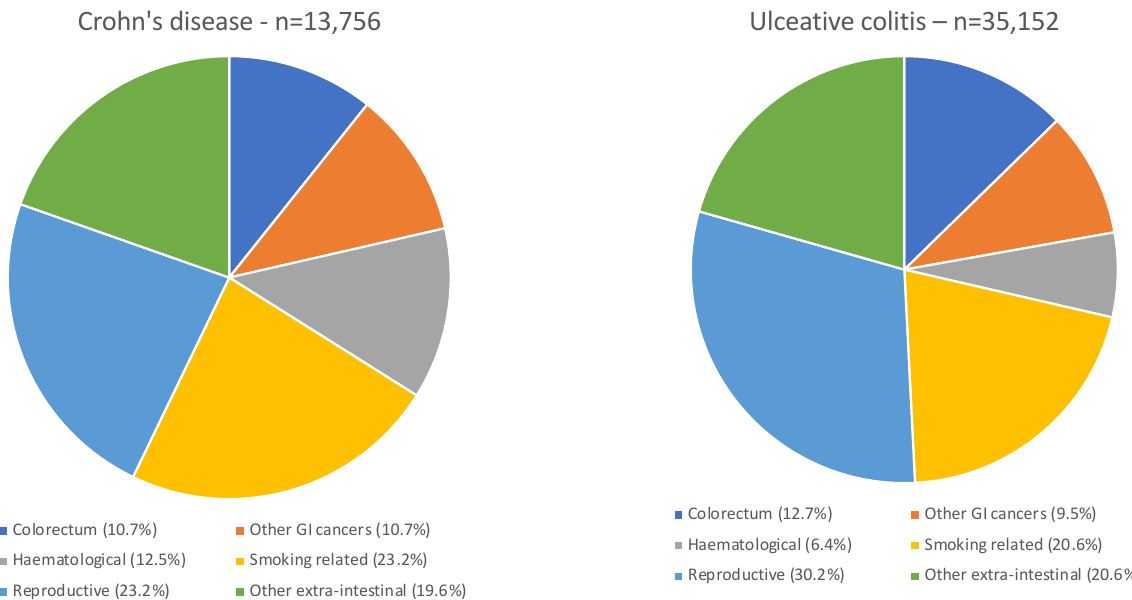
Figure 1. Cancers in a Danish nationwide population-based cohort study of patients with Crohn’s disease and ulcerative colitis with 30 years of follow-up